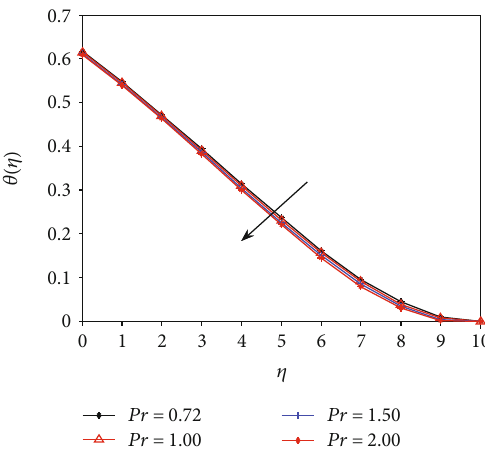
Figure 6: Temperature pro fi les for sundry values of Pr once λ = M = Gr = Ra = Bi = 0 : 1 .